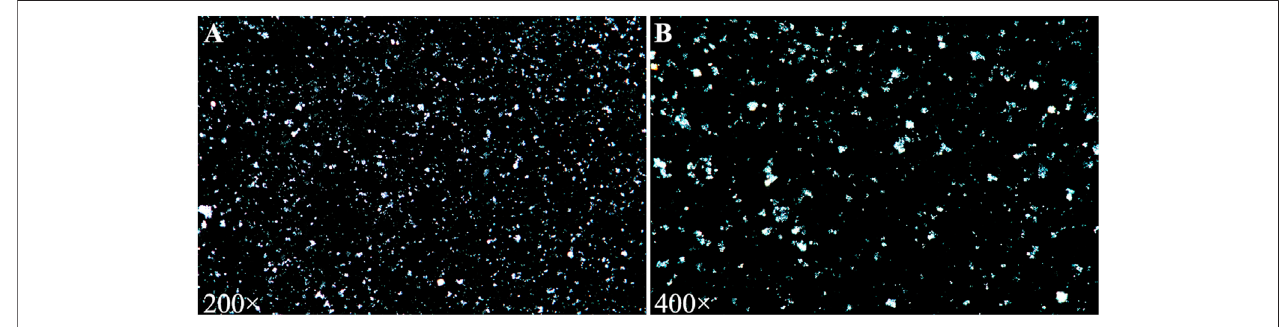
FIGURE 2 | Urine sediment examination showing amorphous and colorless uric acid crystals under a polarizing microscope [ (A) 200 × ; (B) 400 × ].